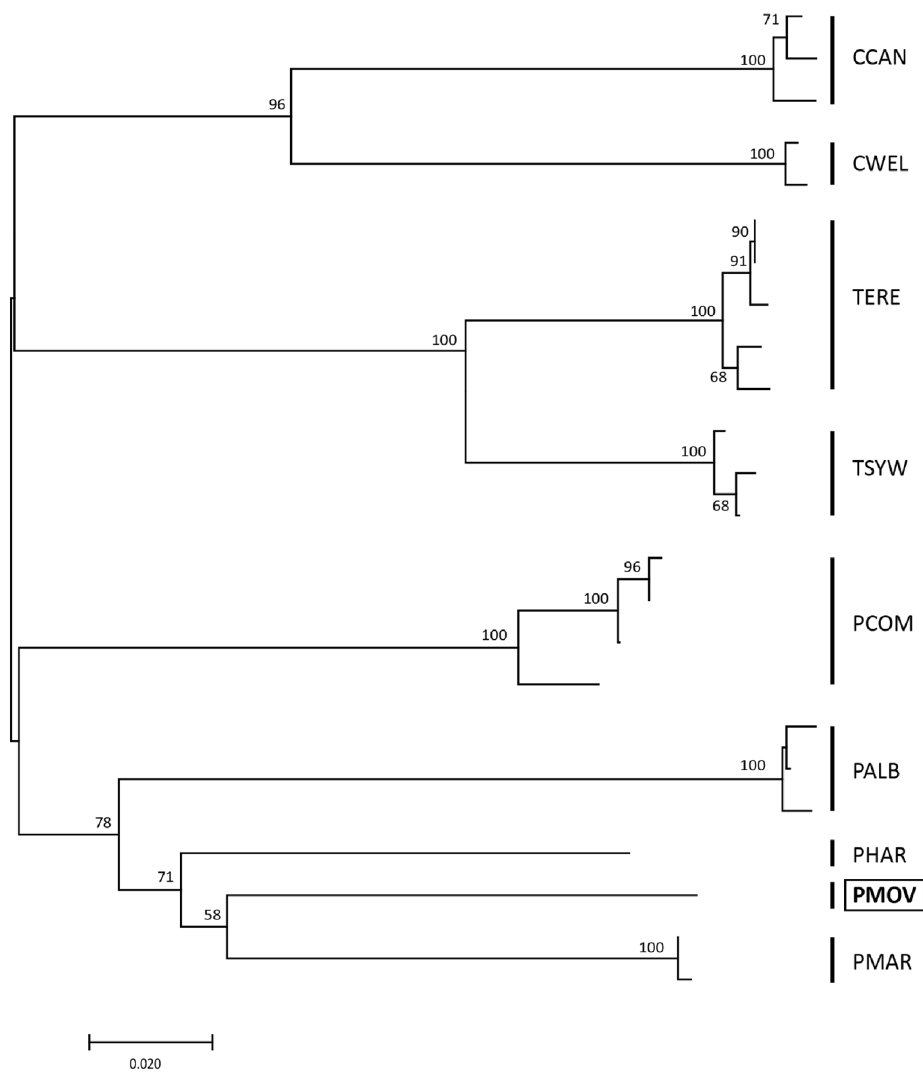
Figure 4. Neighbor-joining tree of the studied ostracod species based on the COI gene sequences (for species codes see Table 1). The distances were calculated with Kimura 2-parameter method. The numbers in front of the nodes indicate bootstrap support (1000 replicates, only values higher than 50% are